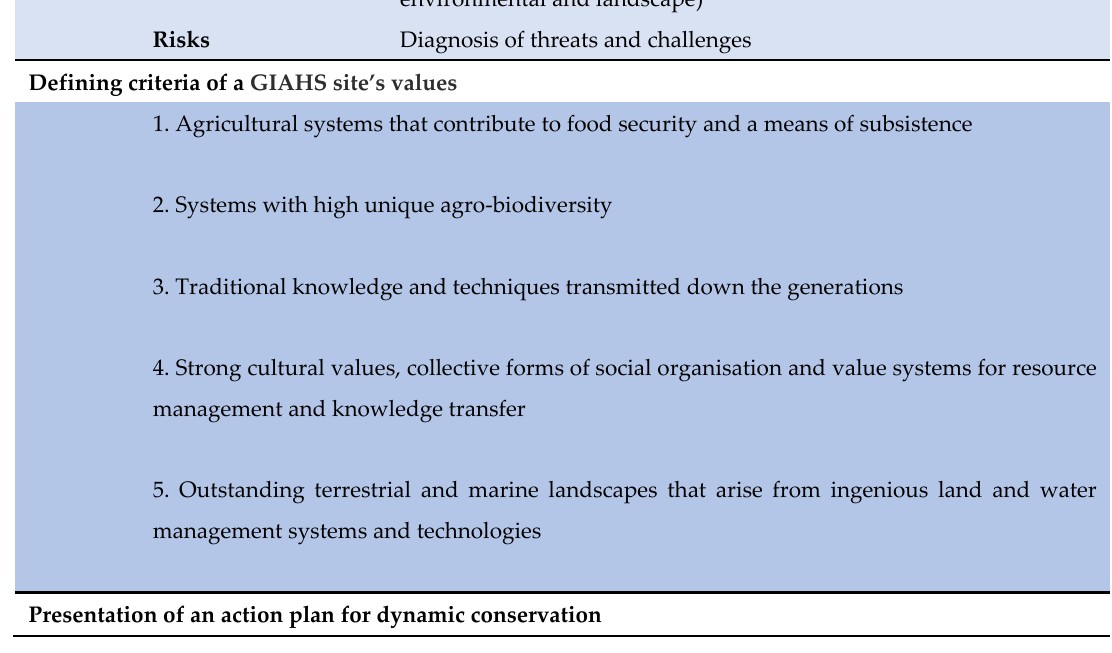
Figure 3. Requirements and criteria for GIAHS candidates. Source: Prepared by authors.